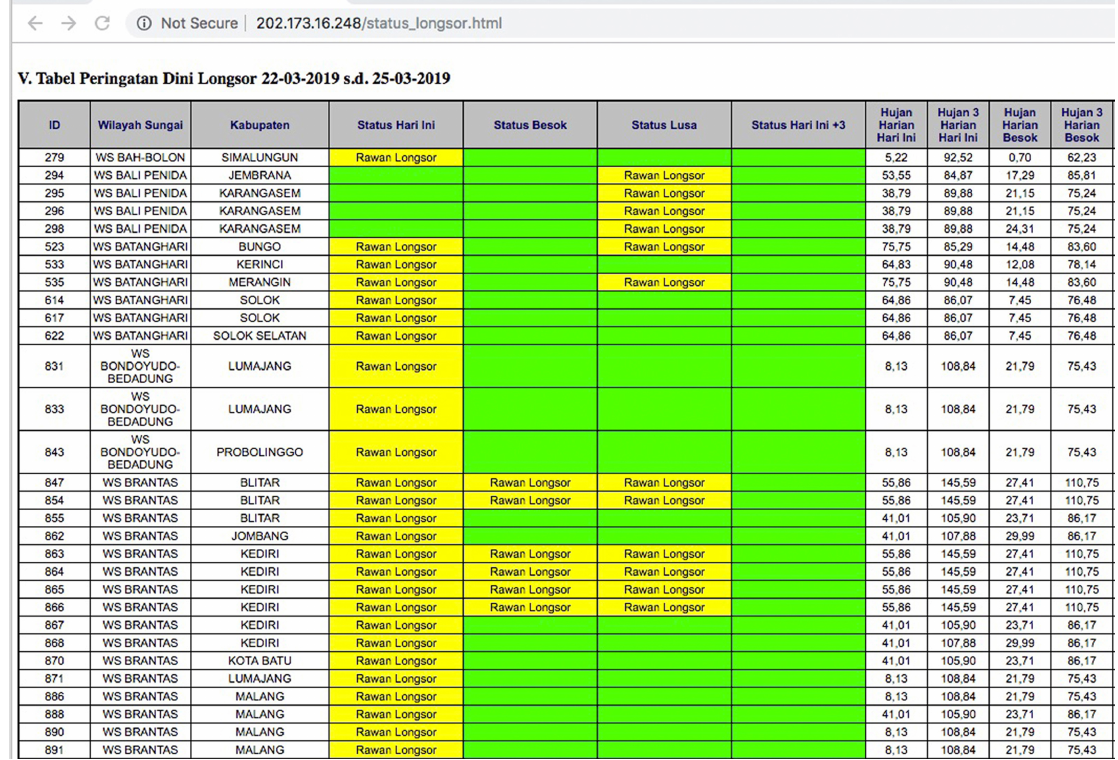
Figure 6. An example of detailed LEWS information displayed on the Balai Litbang Sabo (BLS)